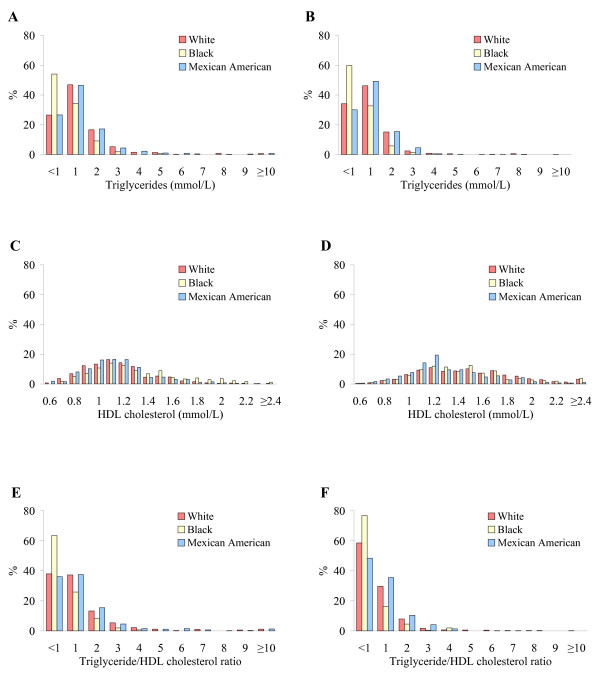
Distribution of triglycerides, HDL-C, and the TG/HDL-C ratio in original metric scale by sex and race/ethnicity. A, triglycerides in men; B, triglycerides in women; C, HDL-C in men; D, HDL-C in women; E, the TG/HDL-C ratio in men; and F, the TG/HDL-C ratio in women.